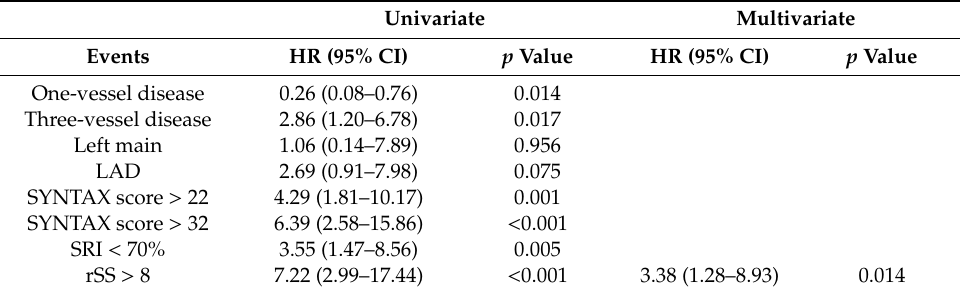
Table 7. Cont. Univariate Multivariate